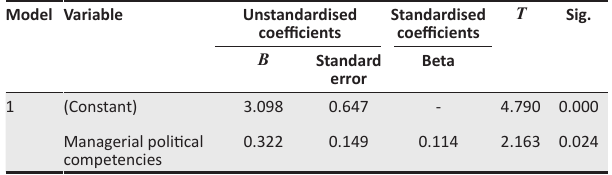
TABLE 6: Regression results of managerial political competencies and return on investment.